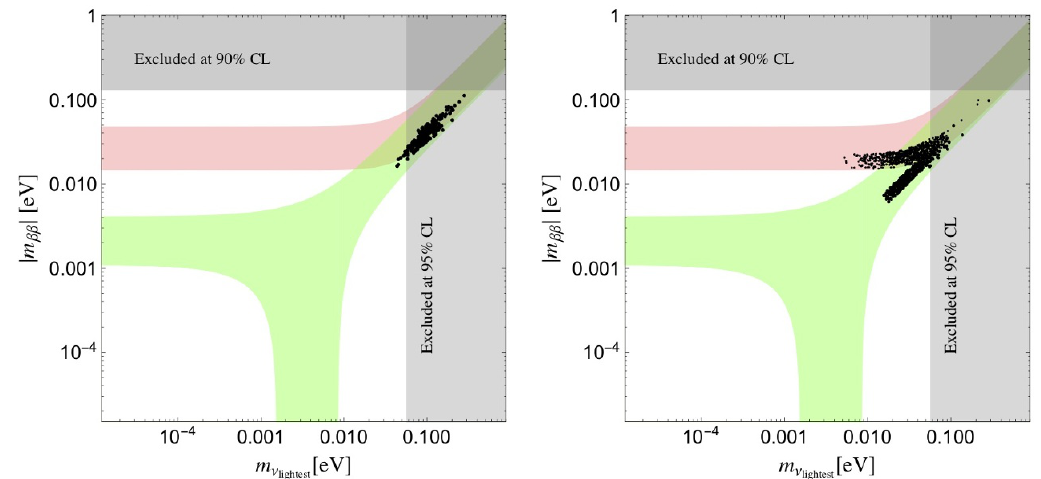
Figure 2 . Correlations between the e(cid:11)ective neutrinoless double beta decay mass and the lightest neutrino mass in case of n = 2 (with (cid:13) = 0, x = (cid:0) (cid:17) 1 = (cid:17) 2 = 1). The left (right) panel corresponds to (cid:15) max = 0 : 02 (0 : 1). The black points in both the panels are in agreement with the results of